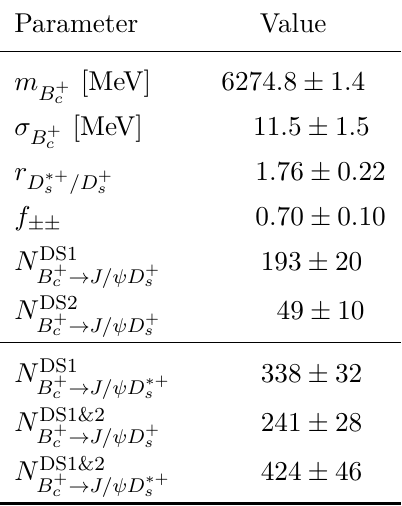
Table 1 . Parameters of the B + extended maximum-likelihood fit to the data. Only the statistical uncertainties are included. No acceptance or efficiency corrections are applied to the signal